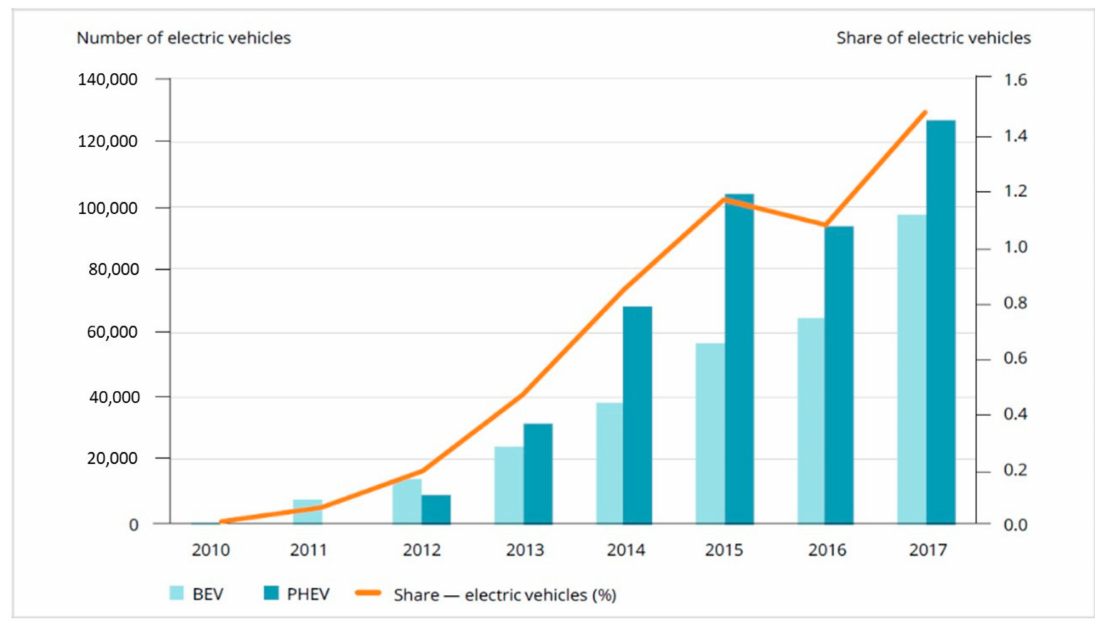
Figure 1. Market Share of New Electric Vehicles in Europe